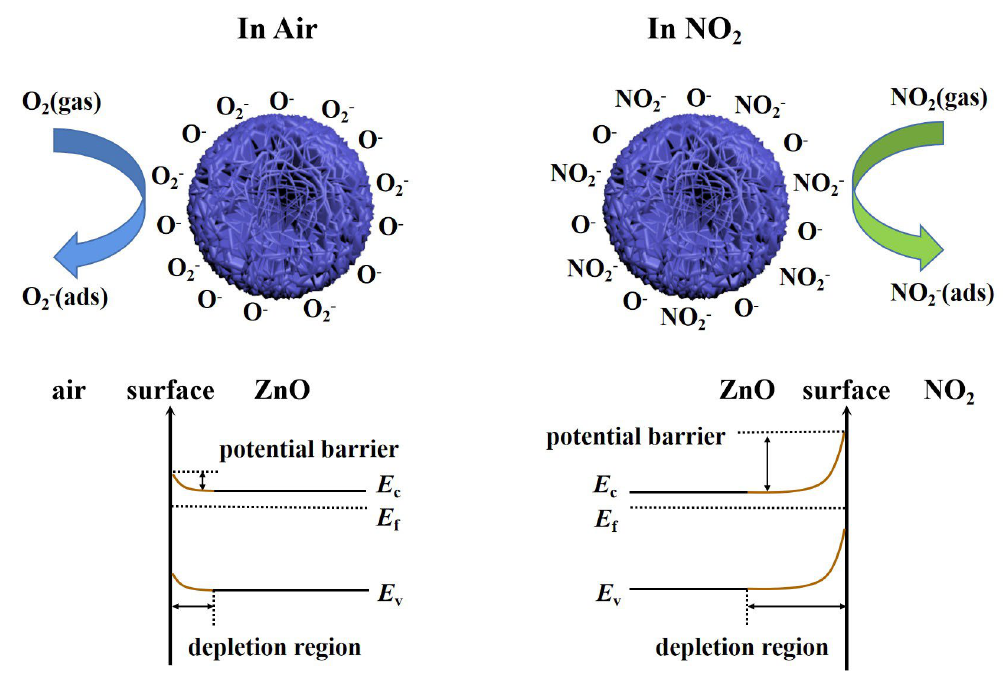
Figure 8. Sensing mechanism of the ZnO nanosheet −flower gas sensor.